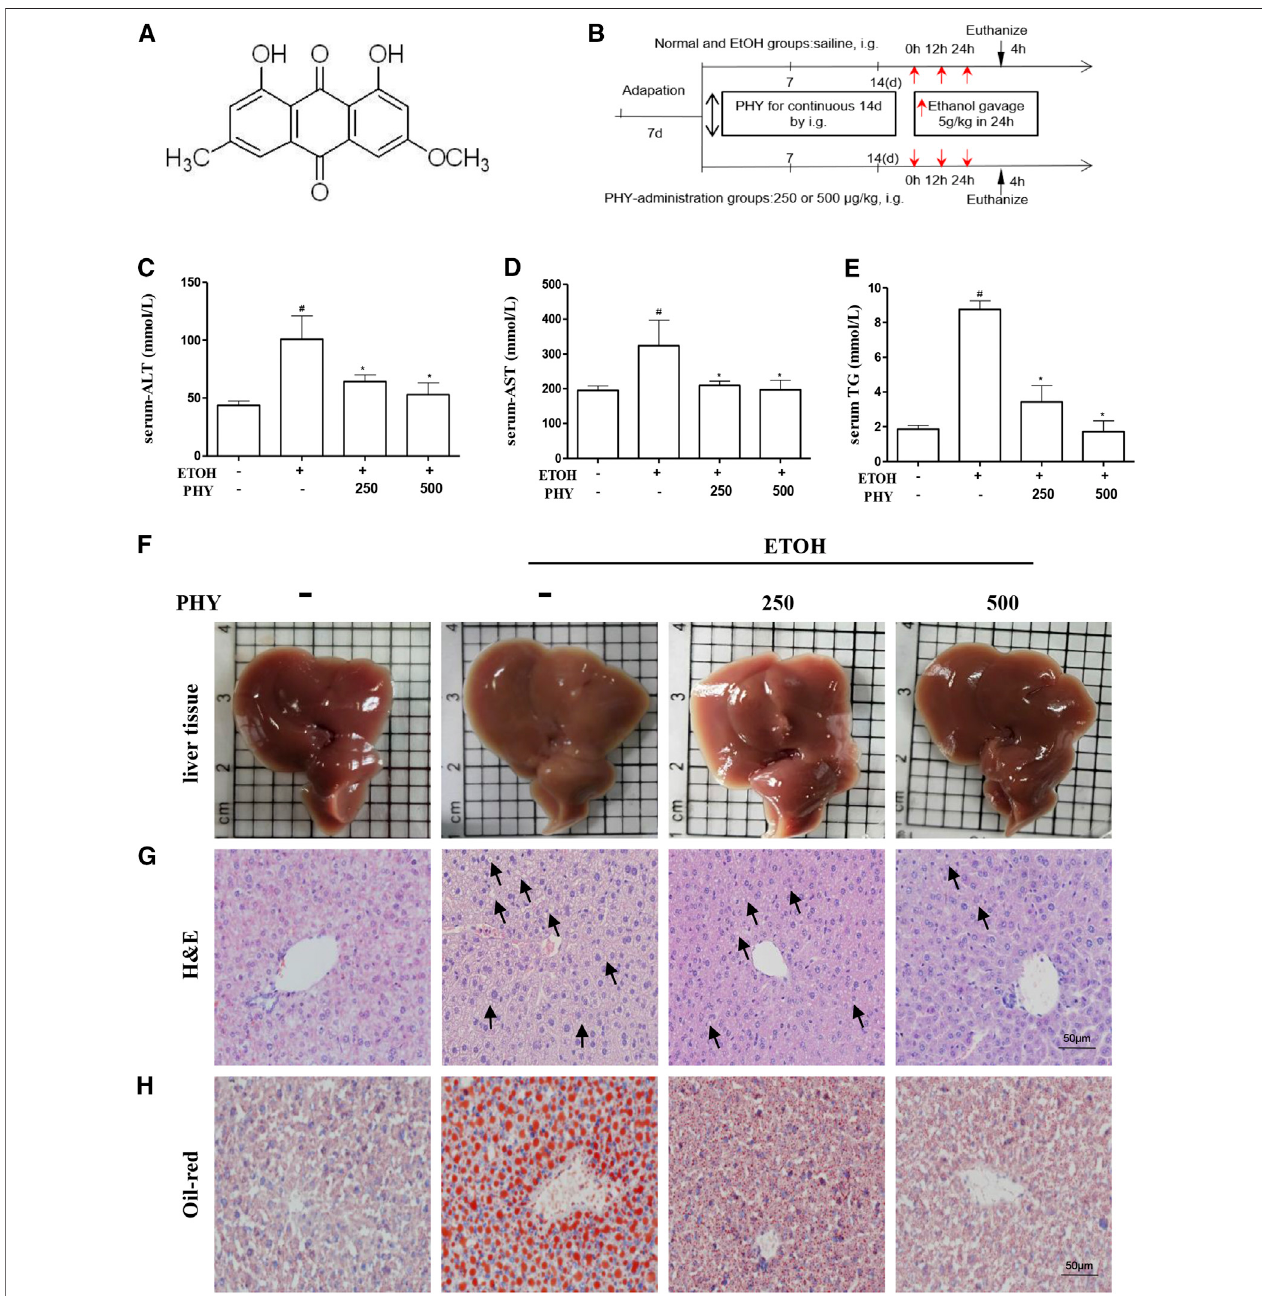
FIGURE 1 | Physcion reduces the symptoms of ethanol-induced hepatic injury. (A) Chemical structure of physcion, (B) animal experimental procedure, (C – E) serum ALT, AST,and TGcontents, (F) liverappearancepictures, (G) H&Estaining,and (H) OilRedOstaining.Valuessigni fi cantlydifferentfromthecontrolareindicated by hash signs ( # p < 0.05). Values signi fi cantly different from the ethanol are indicated by asterisks (* p < 0.05).